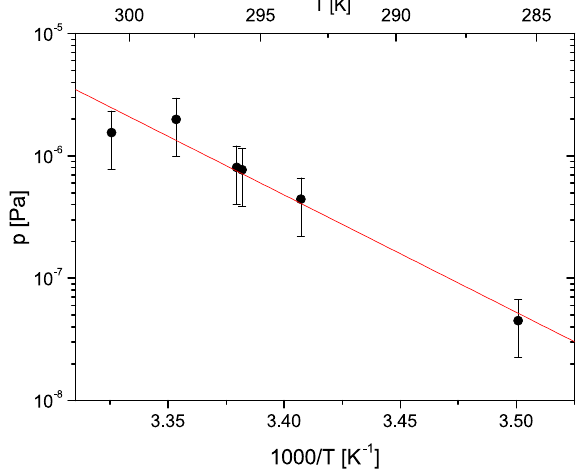
Figure A6. Vapor pressure of 3-MBTCA as function of inverse tem- perature (bottom scale) and temperature (top scale). An Arrhenius fit (red line) yields a vapor pressure at 298.15K of ( 1 . 4 ± 0 . 5 ) × 10 − 6